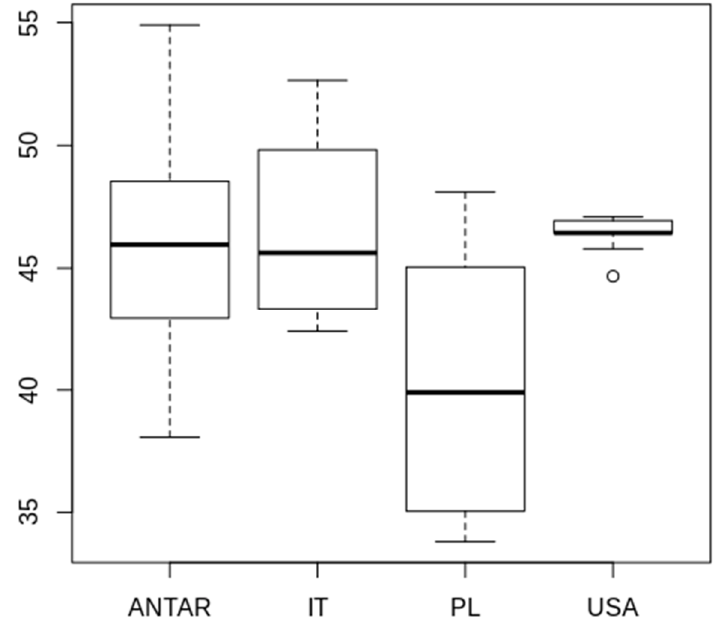
Figure 7. Differences in the stylet supports insertion points (in micrometres ( μ m)) between the studied populations of Paramacrobiotus fairbanksi Schill, Förster, Dandekar and Wolf [25] (Antar, Antarctic; IT, Italy; PL, Poland; USA, USA). Minimum, maximum, median, first quartile, and third quartile for each population are presented.